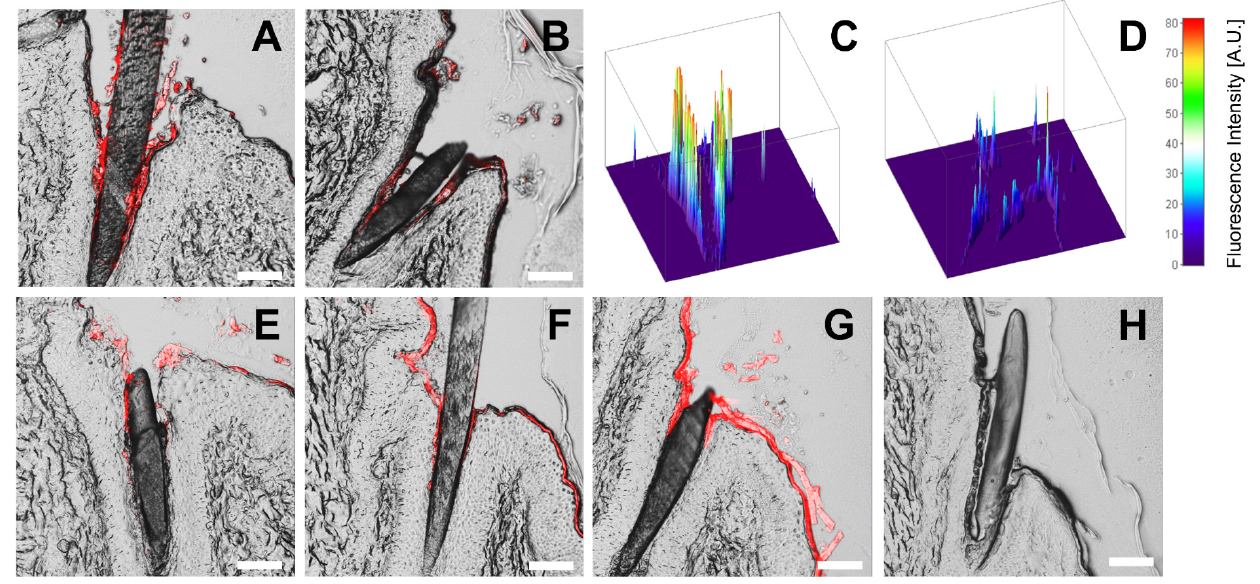
Figure 9. Representative confocal laser scanning microscopy (CLSM) images showed a significant difference of fluorescence intensity (depicted in red) before irradiation of HES-NCs in CH (1144f) ( A ) and after irradiation with UVA light ( B ) which indicated a release of the model drug SR101 from the HES-NCs (by the decrease in fluorescence intensity). The intrafollicular fluorescence intensity is further shown in pseudo-color 3D-plots for HES-NCs in CH before irradiation in ( C ) and after irradiation with UVA light in ( D ). No difference in fluorescence intensity and a slightly reduced penetration depth was noticed after transfer of the HES-NCs to PBS before ( E ) and after ( F ) irradiation with UVA but still higher in comparison to pure SR101 solution ( G ). No fluorescence was observed in untreated follicles ( H ). Scale bars correspond to 100 μ m.